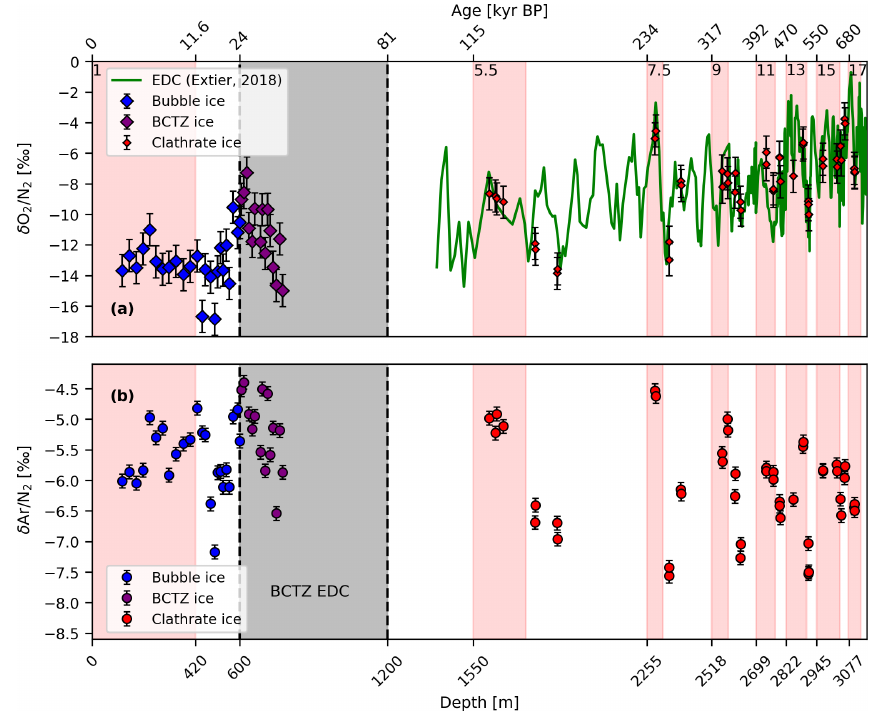
Figure 8. Measurements of δ O 2 / N 2 and δ Ar / N 2 from the Dome C ice core on the EDC depth scale. The δ O 2 / N 2 record from Extier et al. (2018) is corrected for gravitational enrichment using δ 15 N 2 . Our δ O 2 / N 2 data are corrected for gravitational enrichment using δ 40 / 36 Ar, while the δ Ar / N 2 data are corrected for gravitational enrichment, thermal diffusion, kinetic fractionation, and geological Ar outgassing. The data show a large variability in the BCTZ and reproducible values for clathrated ice. (a) The green line represents measurements from Extier et al. (2018), and diamonds represent the EDC measurements of δ O 2 / N 2 in this study. (b) EDC measurements of δ Ar / N 2 from this study. Interglacial MISs (red shaded areas) as identified by Masson-Delmotte et al. (2010) are labeled for